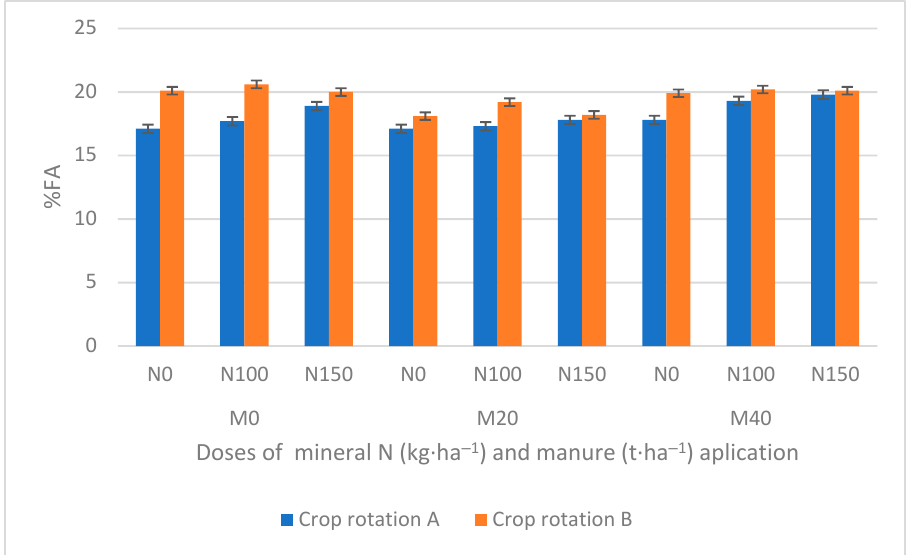
Figure 4. Fulvic acids (FA) contents in in the topsoil layer (0–30 cm) as influenced by crop rotation (I) manure application (III) and inorganic N rate (III) in the long-term field experiment at Grabow, Poland. Error bars denote standard deviations ( n = 3). LSD ( p ≤ 0.05): for I = 0.992, II = 0.448, III = 0.412, II/I = 0.634, I/II = 1.100, III/I = n.s., I/III = n.s., III/II = 0.713, II/III = 0.733.